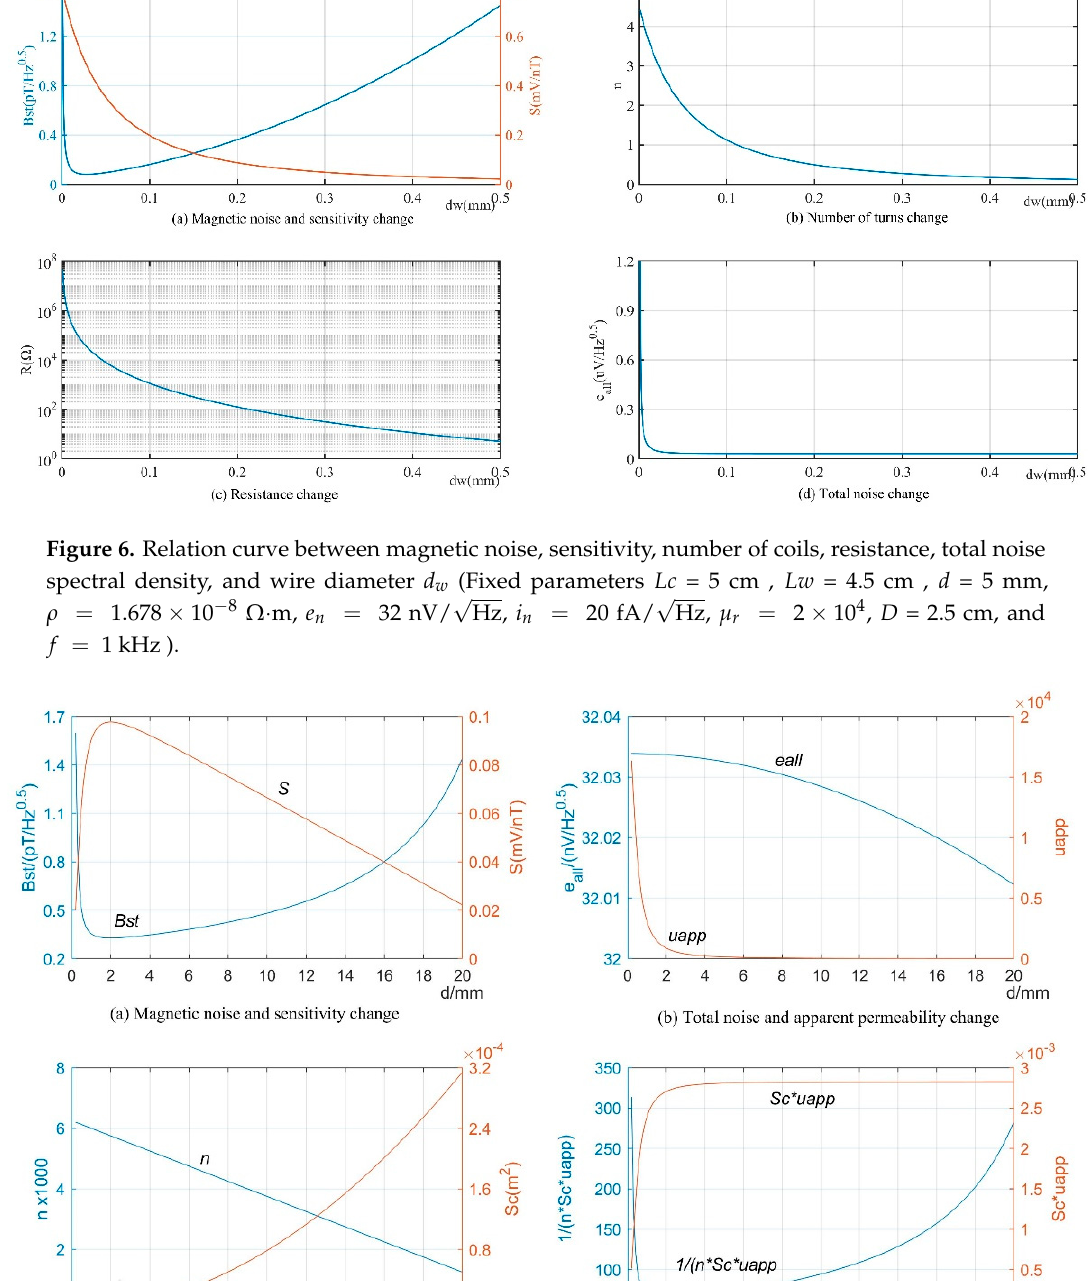
Figure 5 . Equivalent circuit of search coil sensor.